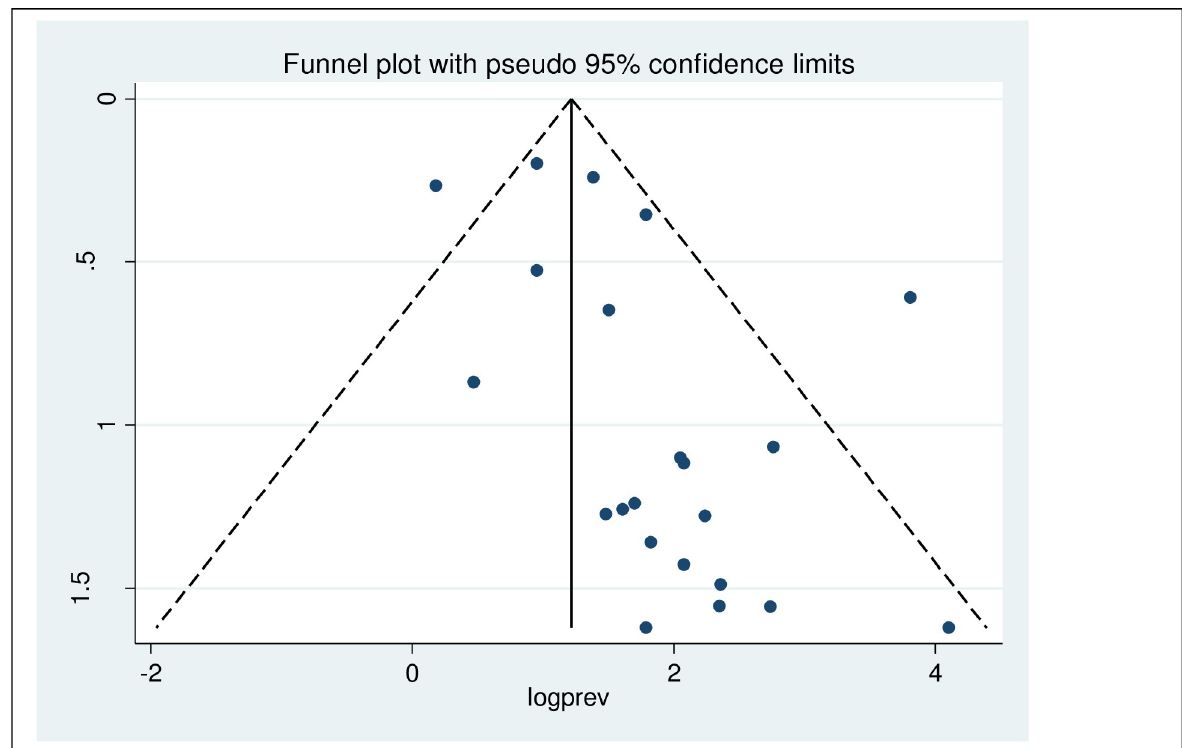
Fig 2. Funnel plot of included studies on the prevalence of HBV among